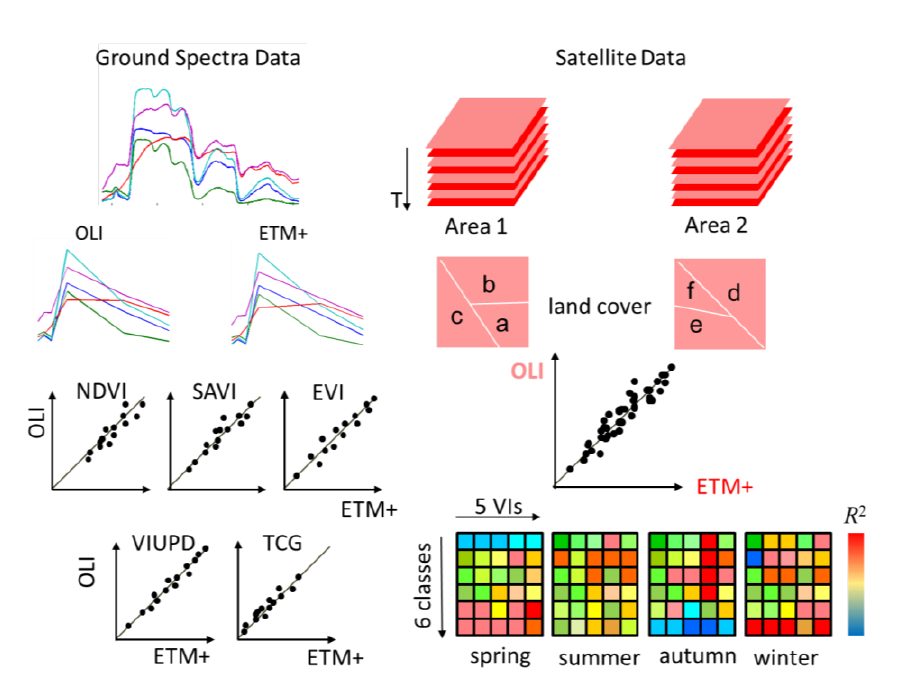
Figure 2. Our method of evaluating the continuity of VIs derived from simulated data ( left ) and satellite data ( right